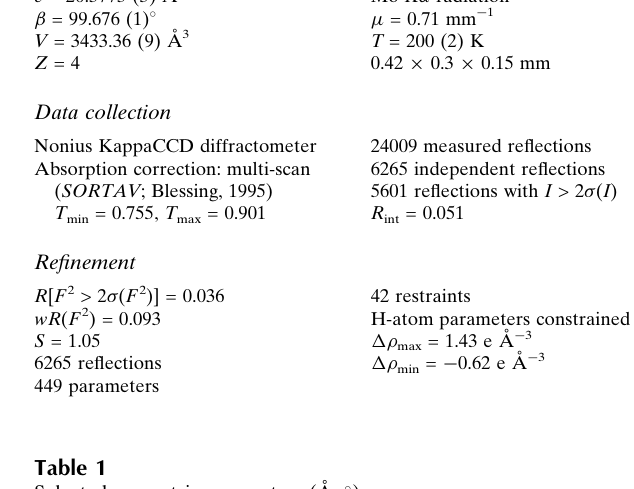
Selected geometric parameters (A˚ , (cid:2)